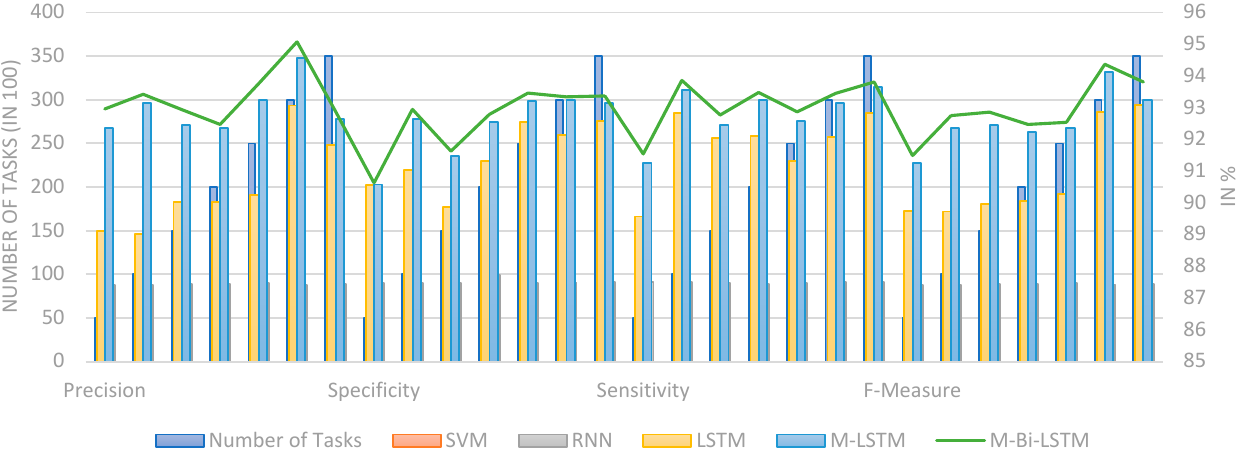
Figure 7. The prediction efficiency analysis.